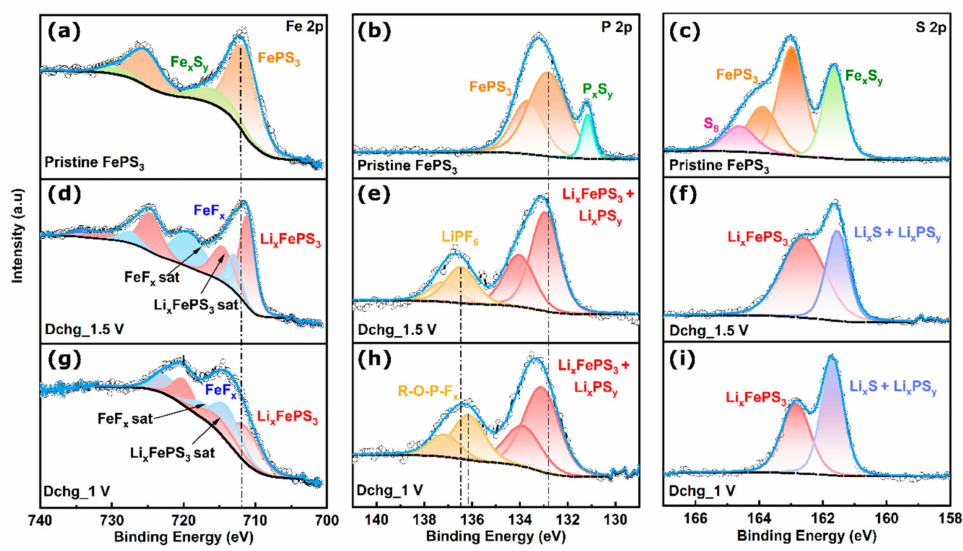
Figure 3. Comparison of high-resolution XPS spectra of pristine FePS 3 and discharged FePS 3 lithium primary battery during different stages of discharge. ( a , d , g ) High-resolution XPS spectra of Fe 2p; ( b , e , h ) high-resolution XPS spectra of P 2p; and ( c , f , i ) high-resolution XPS spectra of S 2p of pristine FePS 3 and discharged FePS 3 until 1.5 and 1